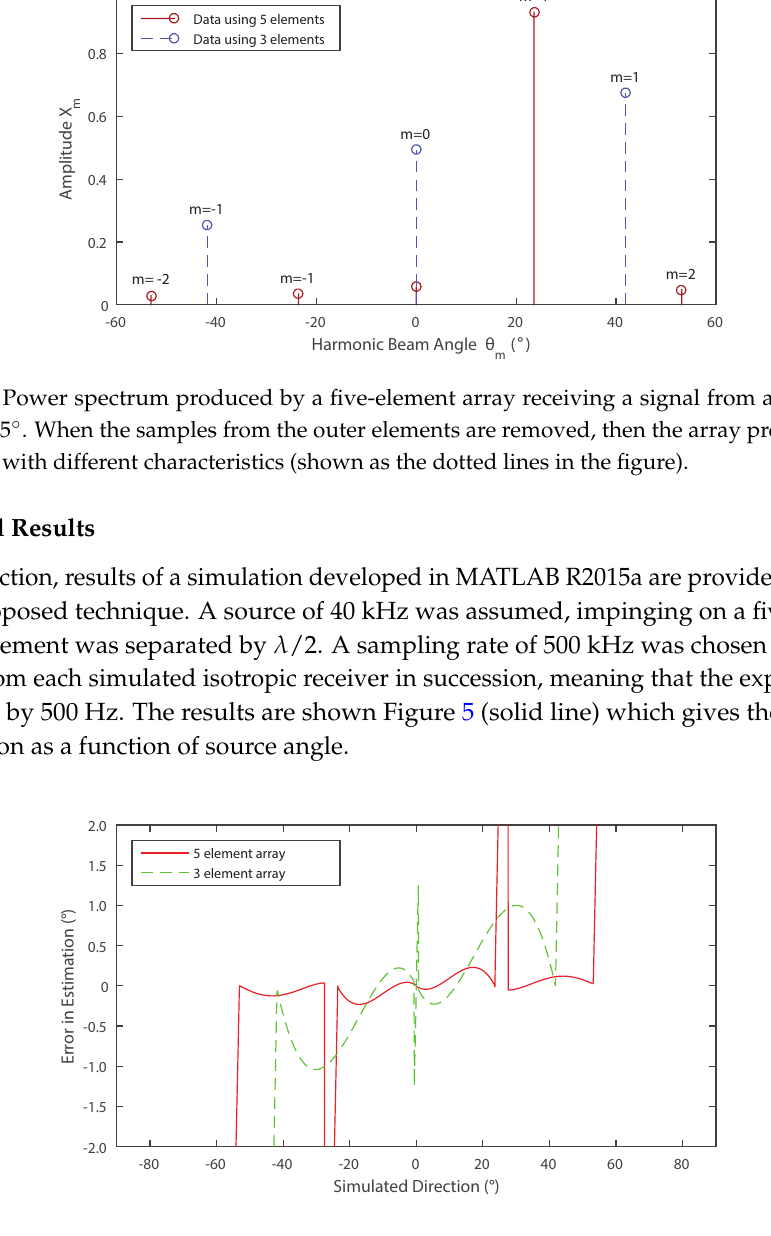
Figure 5. Simulated error in direction of arrival estimation of a linear array using five (solid) or three microphones